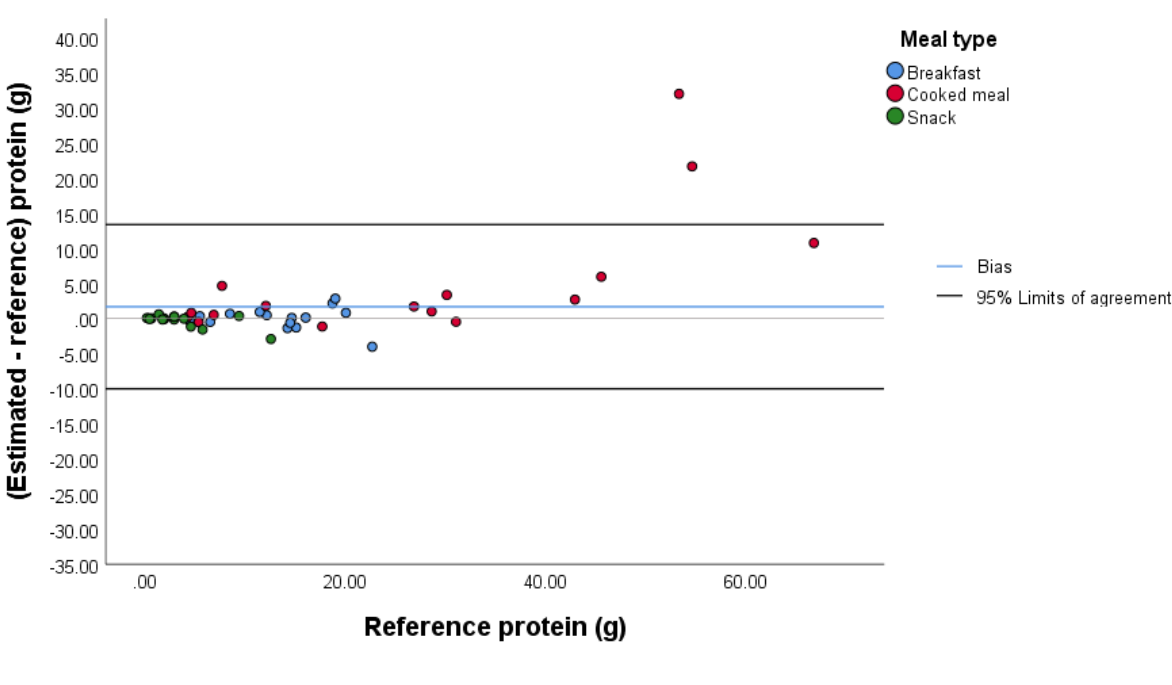
Figure 4. Bland-Altman plot illustrating the difference between the estimated and reference protein content of the meals.